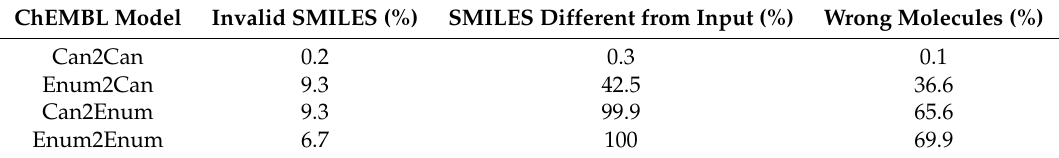
Figure 12. The steps used in the modelling of the QSAR dataset. In step 1, the auto-/heteroencoder is trained on a large unlabelled dataset of molecules from ChEMBL. After training, the encoder part is extracted in step 2 and used to encode the molecules from the QSAR datasets into their latent vectors in step 3. In step 4, a separate standard feed forward neural network is used to build QSAR models from training sets which are subsequently tested with the held-out test set. Table 3. Reconstruction performance on the ChEMBL datasets of the different encoder/decoder configurations.